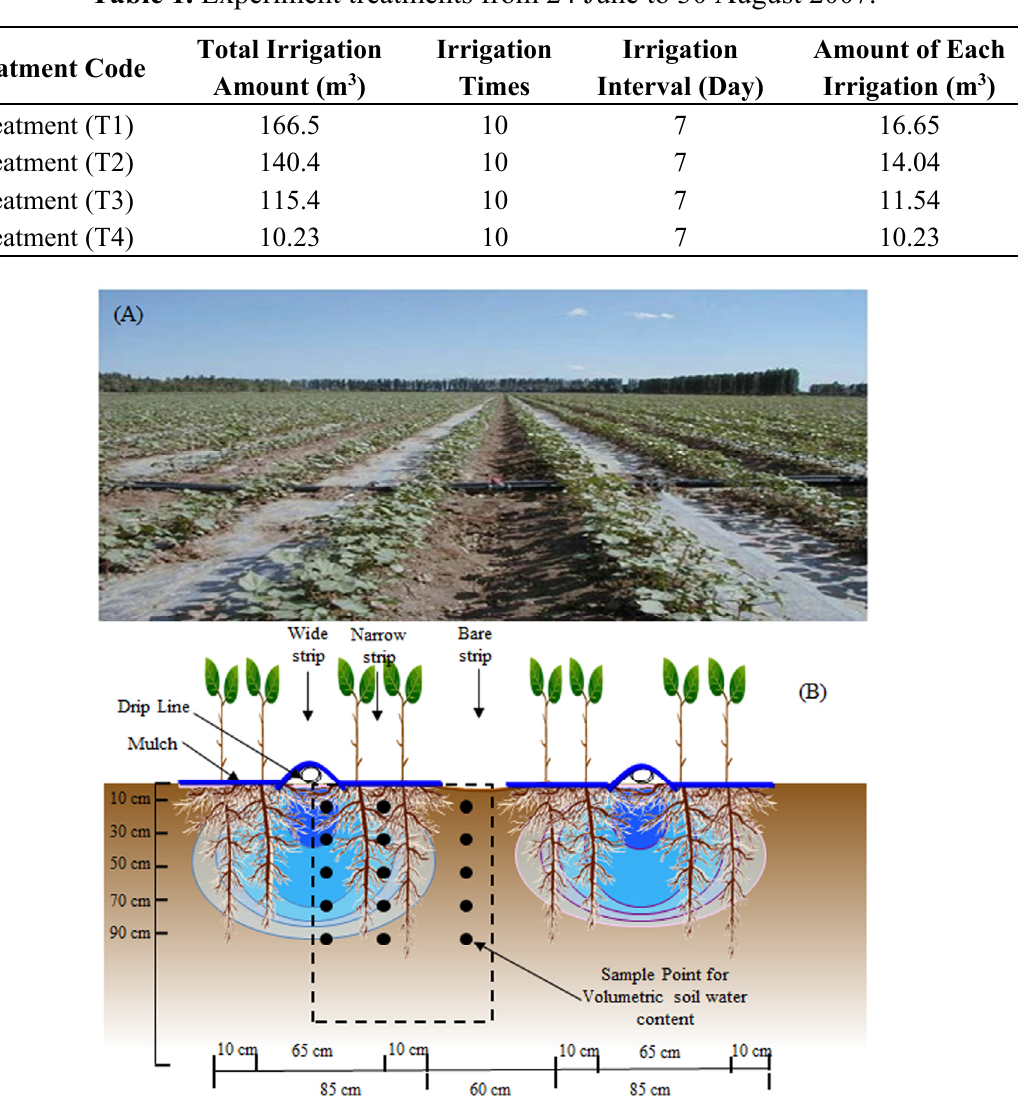
Figure 1. Experiment region ( A ) and the domain geometry of the simulated region and the positions where soil water content was measured ( B